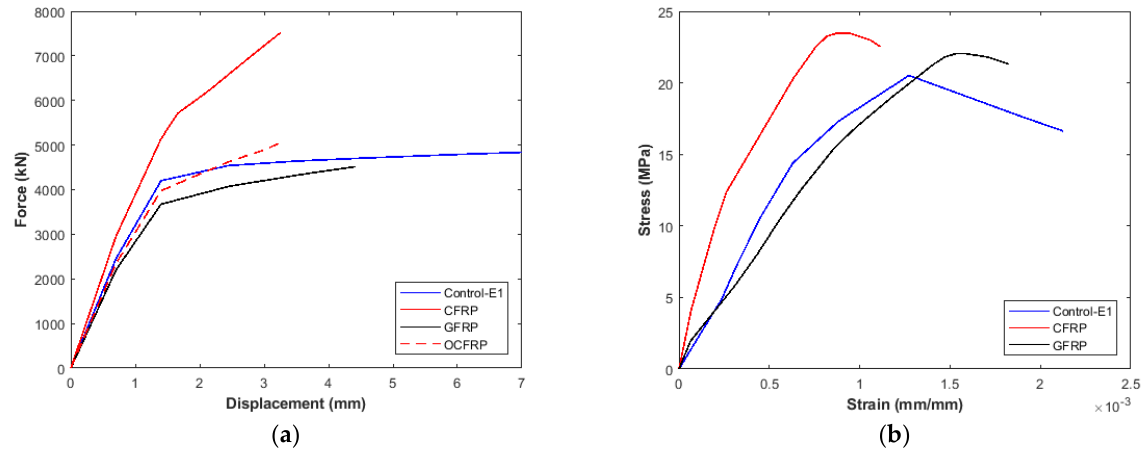
Figure 11. Group E ( a ) Load-Displacement diagram ( b ) Stress-Strain Diagram.